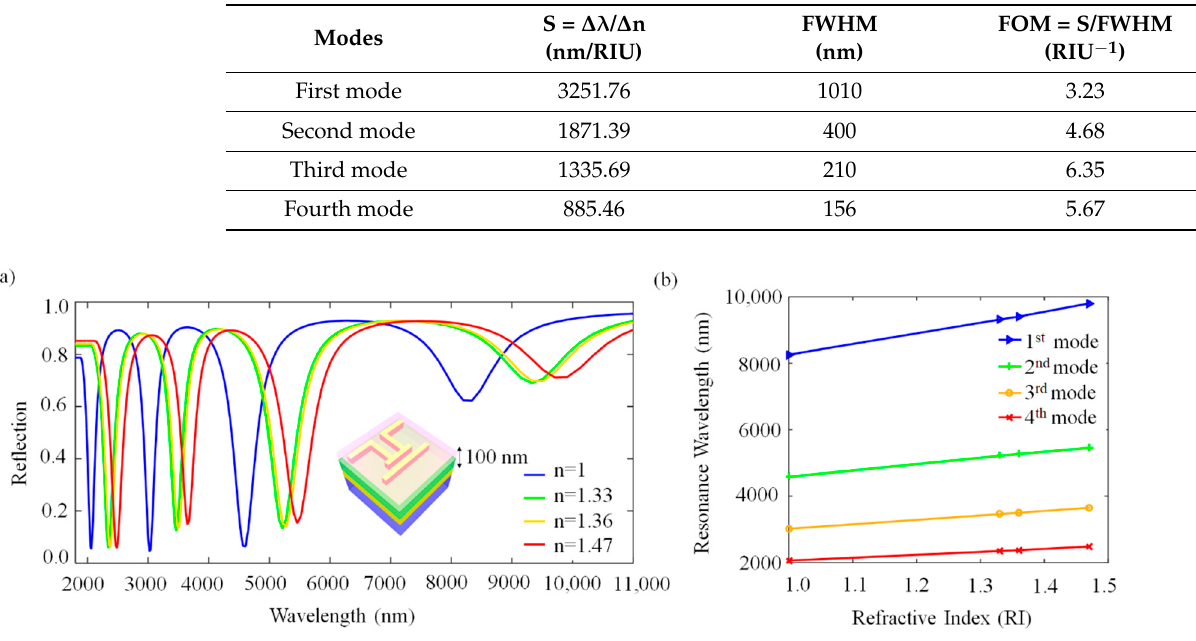
Figure 5. ( a ) Schematic view of embedded PA in 100 nm-thick cladding medium and reflection spectrum of PA with respect to cladding media: air (n = 1), DIW (n = 1.33), acetone (n = 1.36) and glycerol (n = 1.46). ( b ) Linear relationship between resonance wavelengths and refractive index of cladding media for the first, second, third and fourth mode show easy control and calibration of the PA for refractive index-based sensing. The corresponding device parameters: L 1 = L 5 = 550 nm, L 2 = L 4 = 700